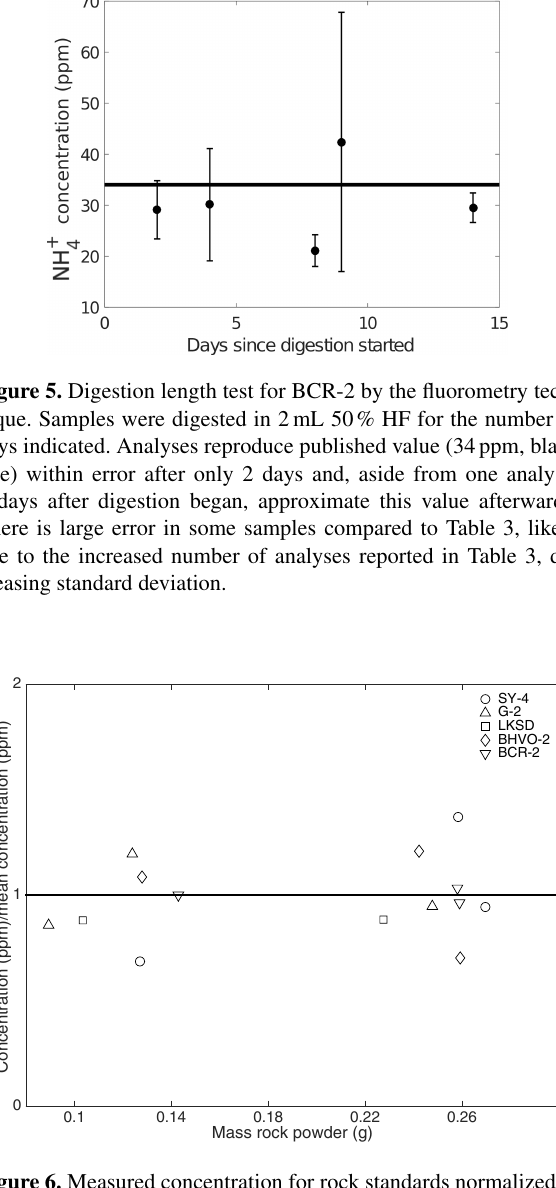
Figure 6. Measured concentration for rock standards normalized to mean concentration from analysis day plotted against the mass rock powder. Symbols represent standards, and all analyses shown are fluorometry with and without distillation. Decreasing initial sample mass does not seem to affect the concentrations calculated, as mea- sured concentrations show no significant trend away from the mean value given the different amounts of rock powder